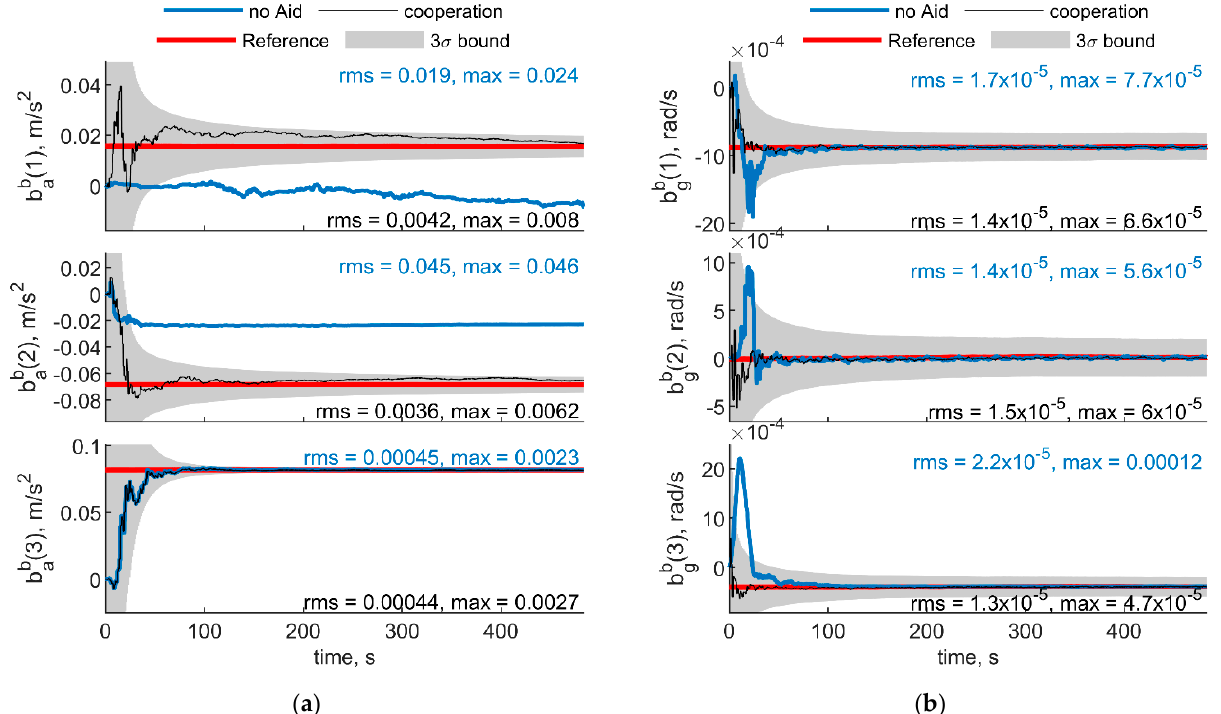
Figure 5. ( a ) Accelerometer and ( b ) gyroscope biases predicted by the filter. Chief trajectory is reported in Figure 3. Two deputies, r = 100 m, μ = 0°, Δχ = 70°. Reference value is reported in red. Results obtained with cooperation and without cooperation have been reported in black and blue, respectively. RMS and maximum error value have been evaluated starting from t = 60 s.